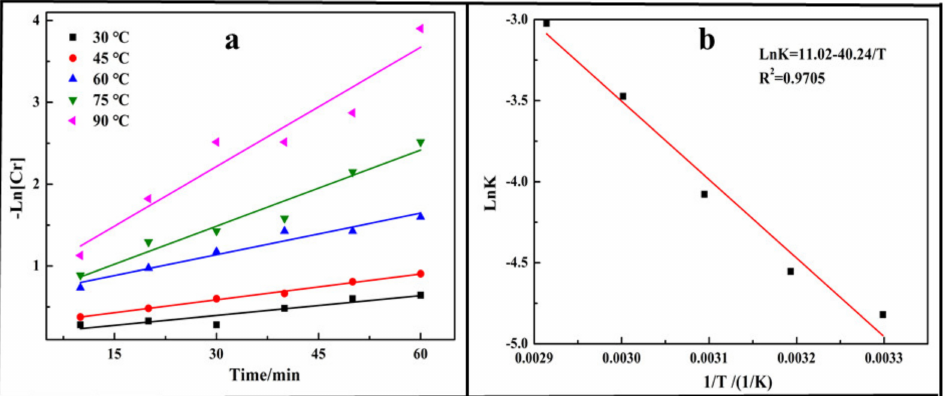
Figure 6. Kinetics plots: ( a ) Plot of reduction kinetics at various reaction temperatures; ( b ) natural logarithm of the reduction reaction constant vs. the reciprocal reaction